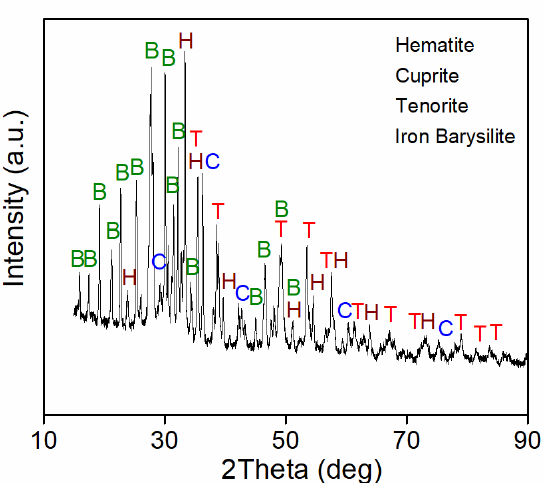
Figure A15. XRD result from the grisaille where burned umber was used. Hematite (H) was identified.